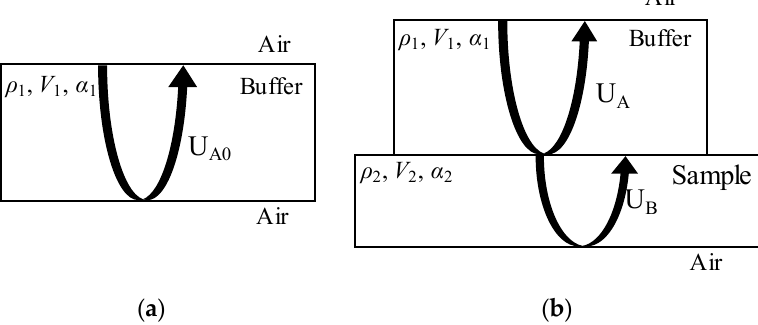
Figure 1. Schematic diagram of the surface reflection measurement principle for measuring the complex reflection coefficient: ( a ) with no sample: reflected wave A 0 of buffer and the air interface; ( b ) with a sample: reflected wave A of buffer and the sample interface, and reflected wave B of sample and the air interface.